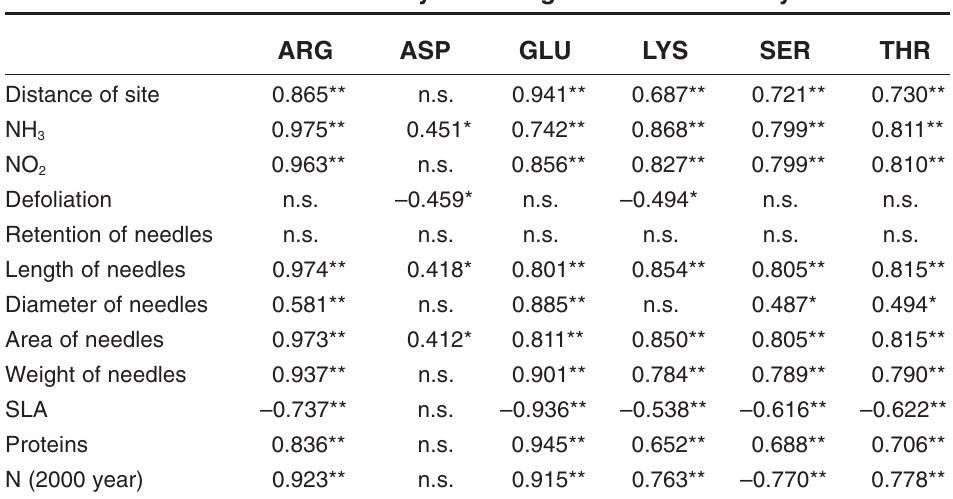
Correlation Coefficients between Site, Tree, Needle Characteristics and Content of Free Amino Acids in Current-Year Needles of P. sylvestris